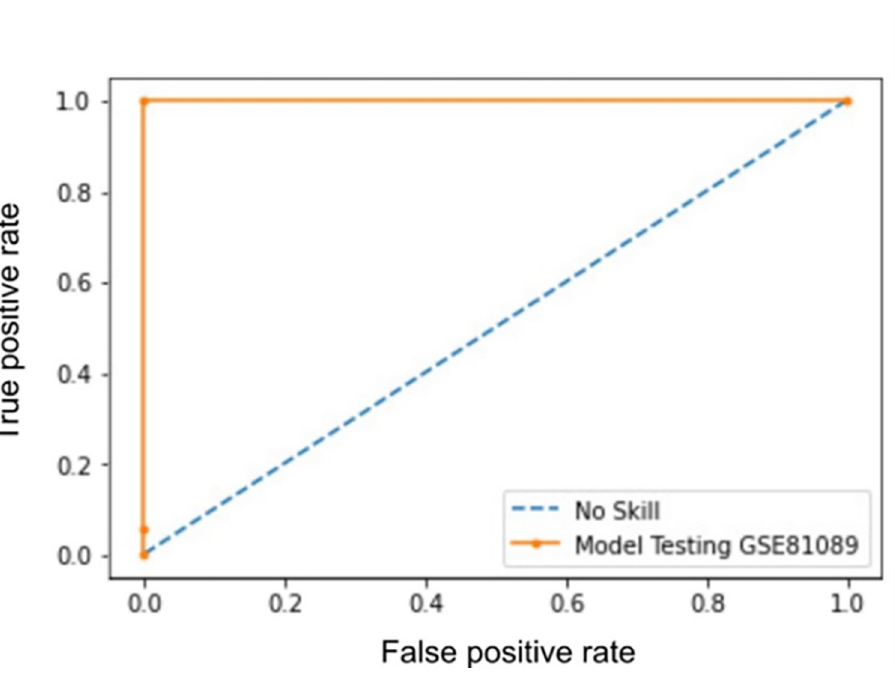
Fig 6. ROC and AUC validation of the proposed model using the external dataset (GSE81809).